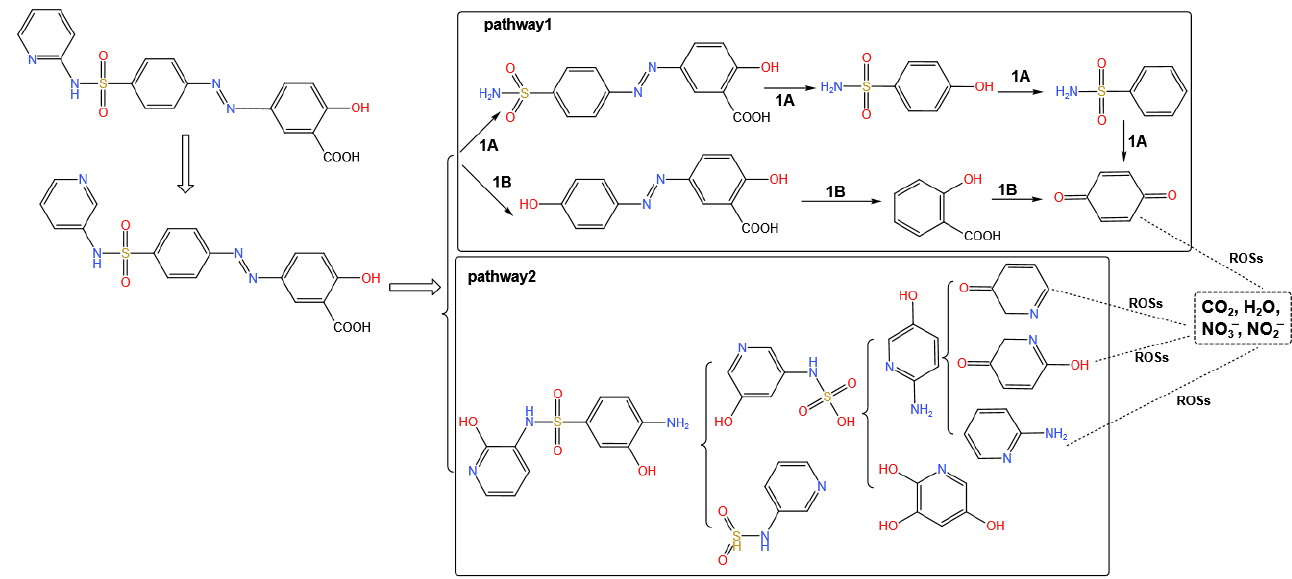
Figure 8. Reaction pathway of oxidation degradation of sulfasalazine by O 3 /H 2 O 2 according to Pelalak et al. [138].